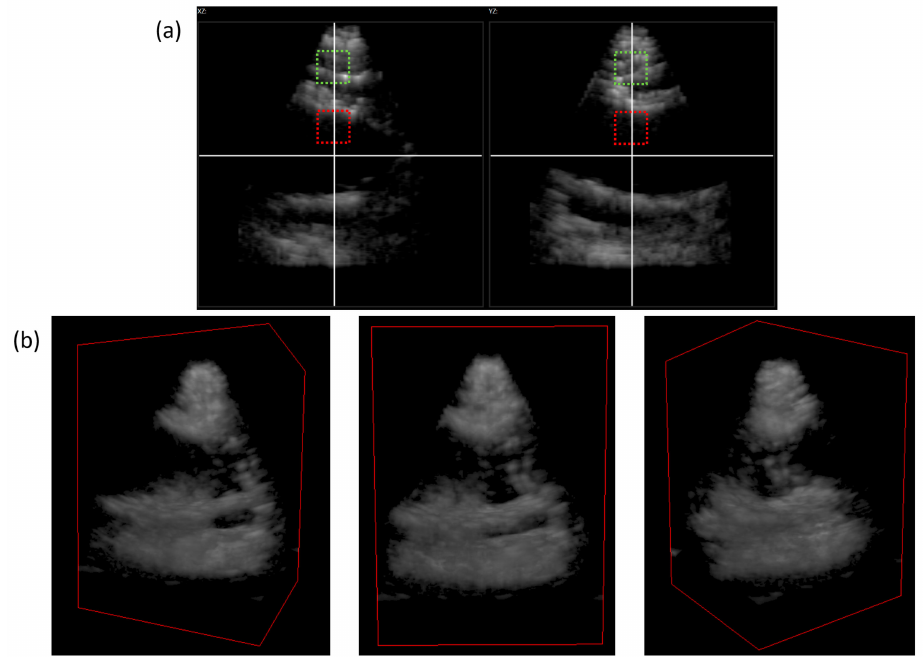
Figure 16. Volumetric imaging of an In Vivo human bladder using the Vermon 32 × 32 matrix array: orthogonal XZ, YZ plane ( a ); volume rendering of the full volume at different angles ( b ).